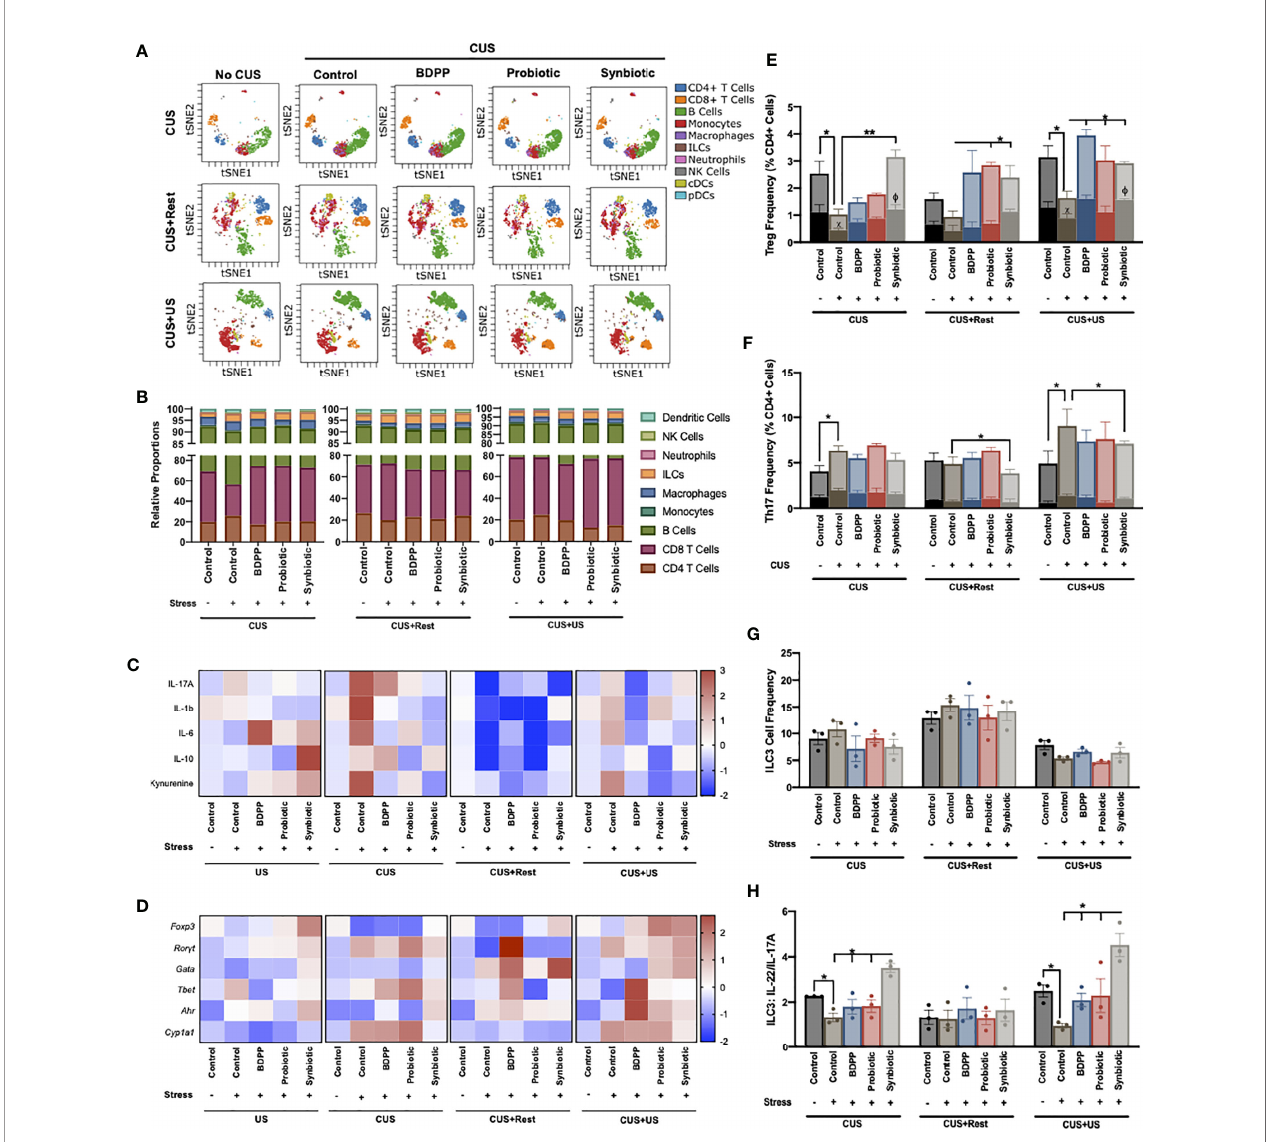
FIGURE 4 | Synbiotic alleviates ileal immune variations in response to chronic and recurrent stress. Immunophenotyping of the ileum was determined with a CyTOF panel and (A) overall visualization of the similarity of major cell populations in a single representative sample is depicted as a viSNE plot. The viSNE plot is two- dimensional fi gure with the axes tSNE1 and tSNE2, with cells plotted on a continuum of expression with phenotypically related cells clustered together based on gating of major cell populations and colored based on cell type called a “ phenotypic island ” . Quanti fi cation of each of these cell populations ( n =3) is shown in (B) . Overall immunological response is depicted as a heatmap of the (C) cytokine and (D) transcriptional pro fi les ( n = 6) and represented as the ratio of relative values of stressed vs. non-stressed for the respective group normalized with the z-score across all timepoints for a single gene or cytokine. A positive z-score is represented with red and a negative z-score with blue. Individual cell frequencies of (E) regulatory T cells (Tregs) and (F) T helper (Th) 17 cells relative to total CD4 + cell populations are shown with a solid color inset of activated Treg (CTLA + ) and Th17 (IL17A + ICOS + ) cells, respectively. Frequency of (G) innate lymphoid cell (ILC)3 relative to total cell populations and (H) the ratio of IL-22 to IL-17A producing ILC3 cells are shown. All cell frequencies represent n = 3 mice +/- SEM with signi fi cance determined with a one-way ANOVA and Tukey ’ s post-hoc analysis where *p < 0.05, **p <